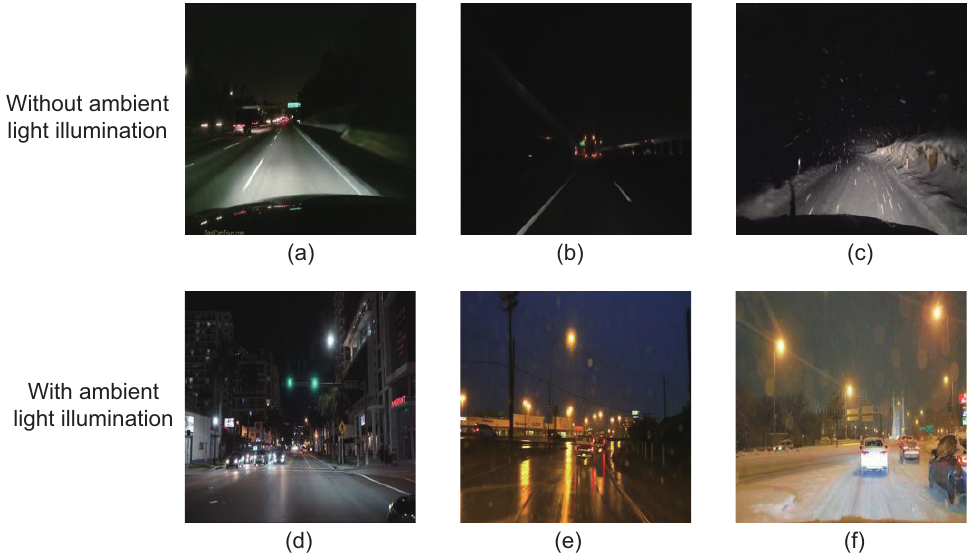
Figure 2. Examples of different road conditions. ( a – c ) are taken without ambient light illumination. ( b , d , f ) are taken under ambient light illumination. ( a , d ) are taken in dry road conditions. ( b , e ) are taken in wet road conditions. ( c , f ) are taken in snowy road